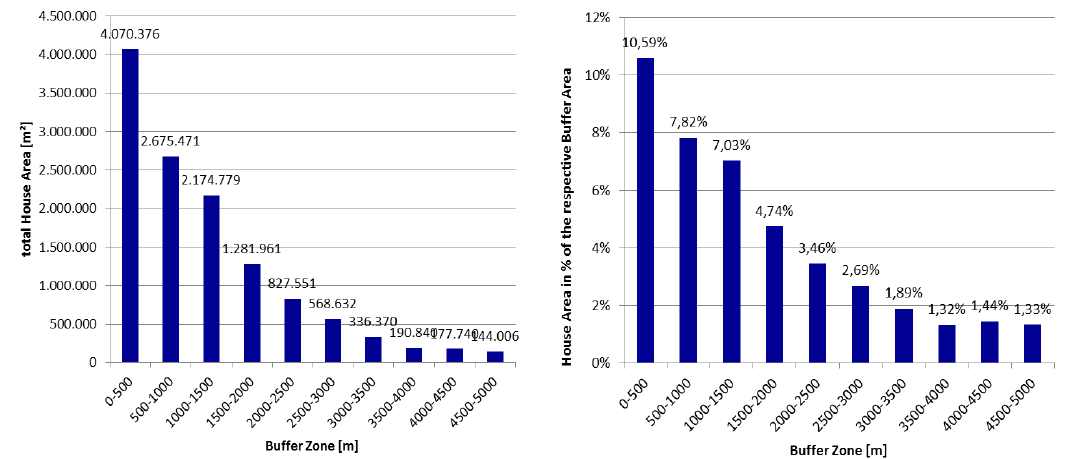
Figure 7. Building area in square meter within the 10 individual buffer zones ( left ) and percentage of the respective buffer zone ( right ) covered with houses (as buffer zones are different in size the percentage is a neutral